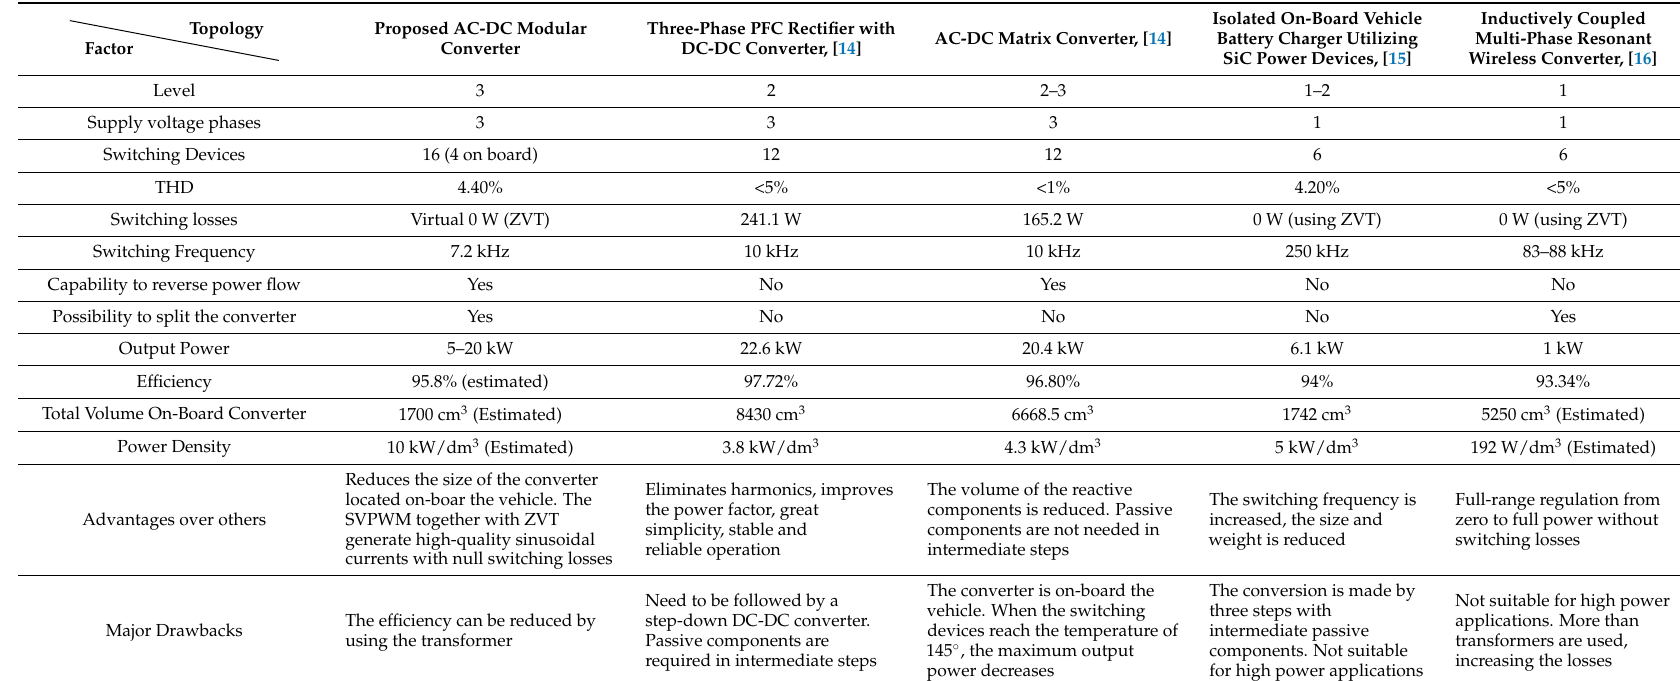
Table 5. Comparison with three other AC-DC